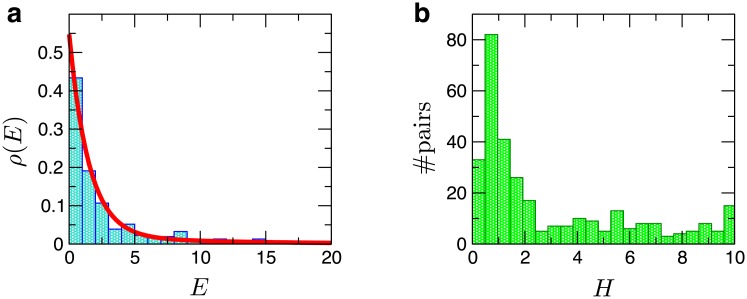
Distributions of efficacy and Hill coefficient.a. Probability density of efficacy ρ(E) and b. the histogram of Hill coefficient for the ensemble of all interacting odorant-OR pairs. ρ(E) was fitted to a sum of two exponentials (Eq 8).